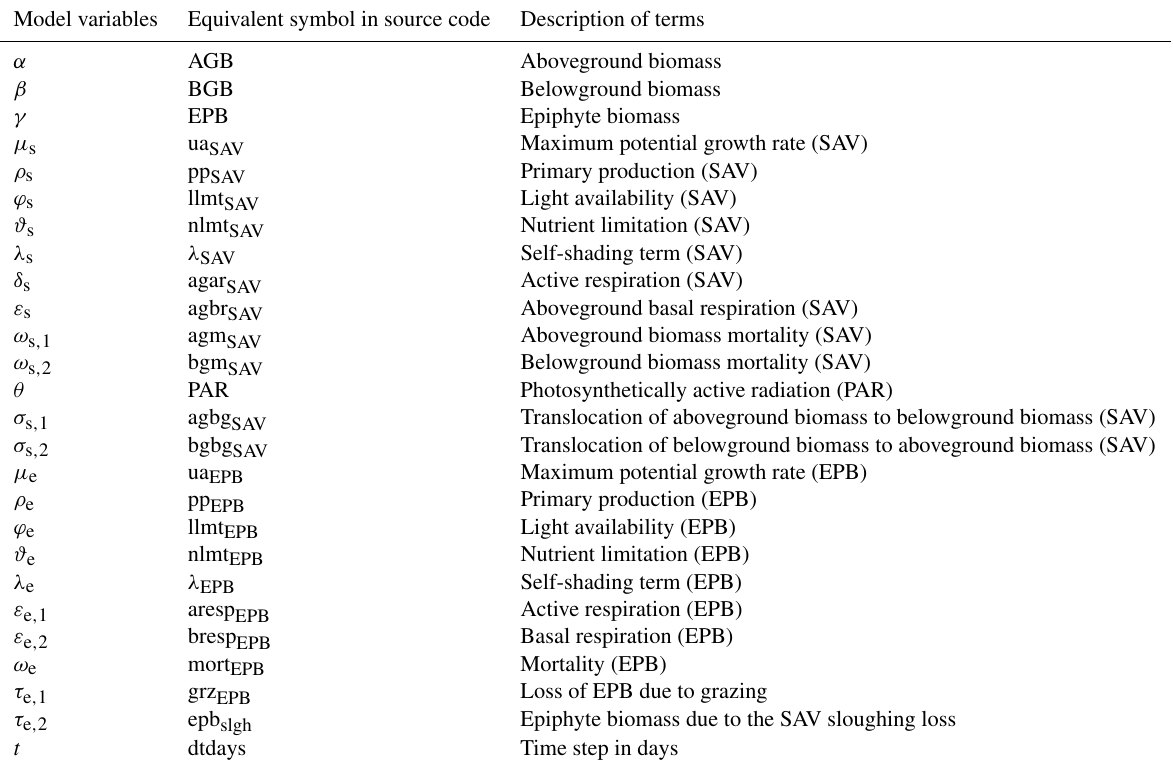
Table 1. SAV growth model variable descriptions. Model